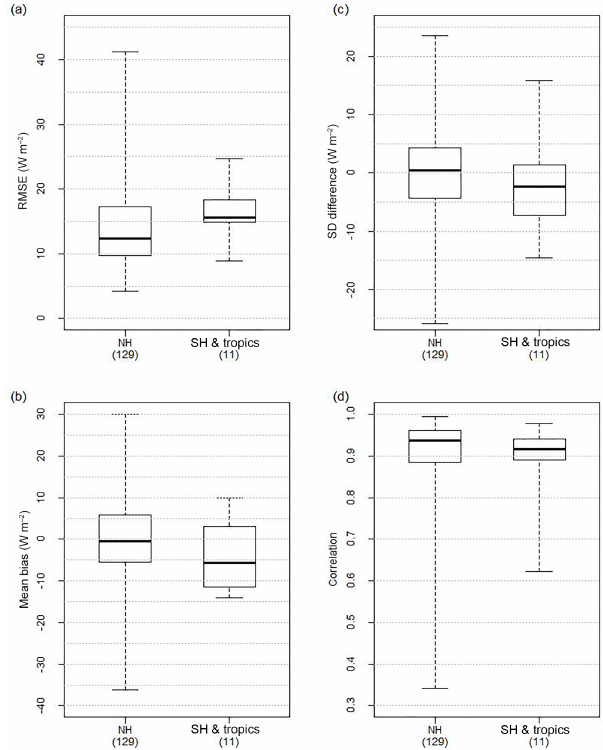
Figure 10. Four statistics – (a) RMSE, (b) mean bias, (c) SD dif- ference and (d) correlation – calculated for DOLCE separately at 129 flux towers located at the Northern Hemisphere excluding the tropics (NH) and at 11 towers in the Southern Hemisphere and the tropics (SH and tropics).